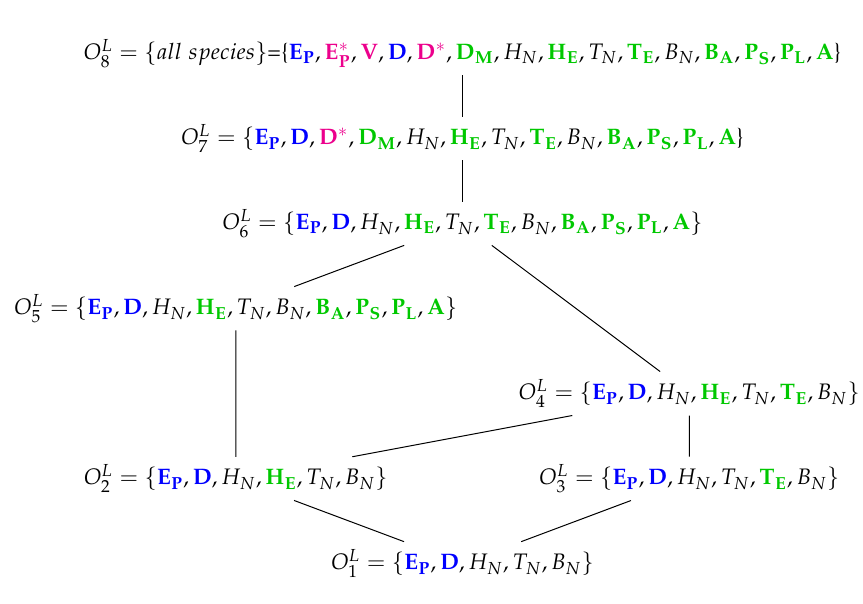
Figure 14. The Lee model [9] which contains 15 variables: uninfected epithelial cells ( E P ), infected epithelial cells ( E ∗ ), virus titer ( EID 50 / ml ) ( V ), immature dendritic cells ( D ), virus-loaded dendritic P cells ( D ∗ ), mature dendritic cells ( D M ), naive CD4+ T cells ( H N ), effector CD4+ T cells ( H E ), naive CD8+ T cells ( T N ), effector CD8+ T cells ( T E ), naive B cells ( B N ), activated B cells ( B A ), short-lived plasma (antibody-secreting) B cells ( P S ), long-lived plasma (antibody-secreting) B cells ( P L ) and antiviral antibody titer ( A ). Note that here we have colored green only those species representing the immune system when